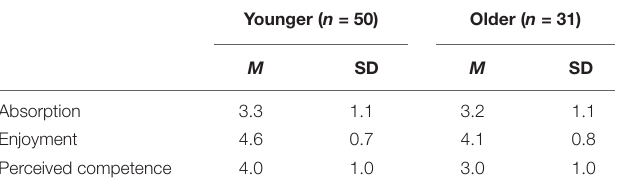
FIGURE 5 | Study 3 content of children’s drawing by age